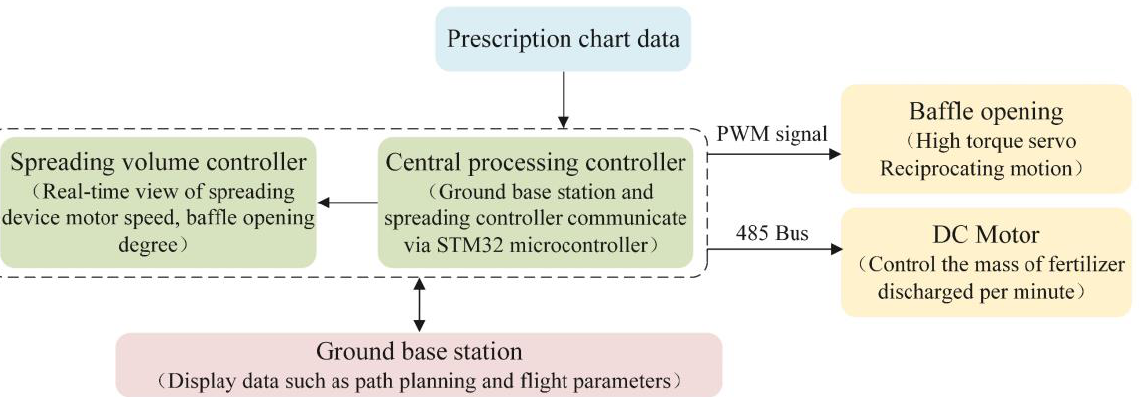
Figure 2. Block diagram of variable fertilization control system.